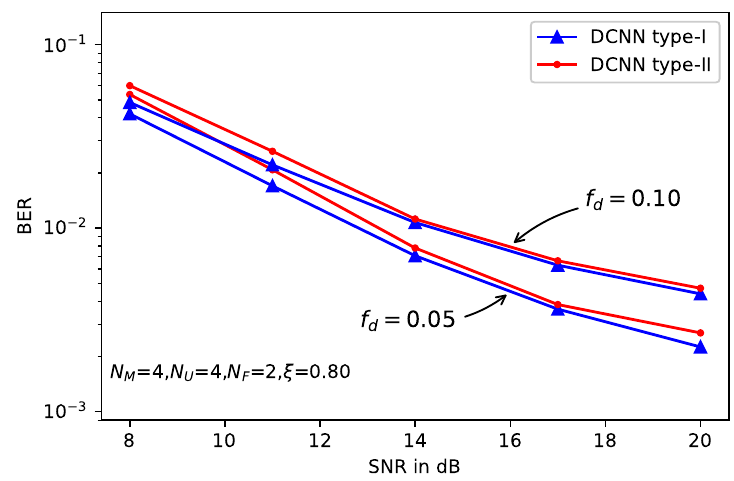
Figure 9. BER performance of deep learning-based MLD with different f d